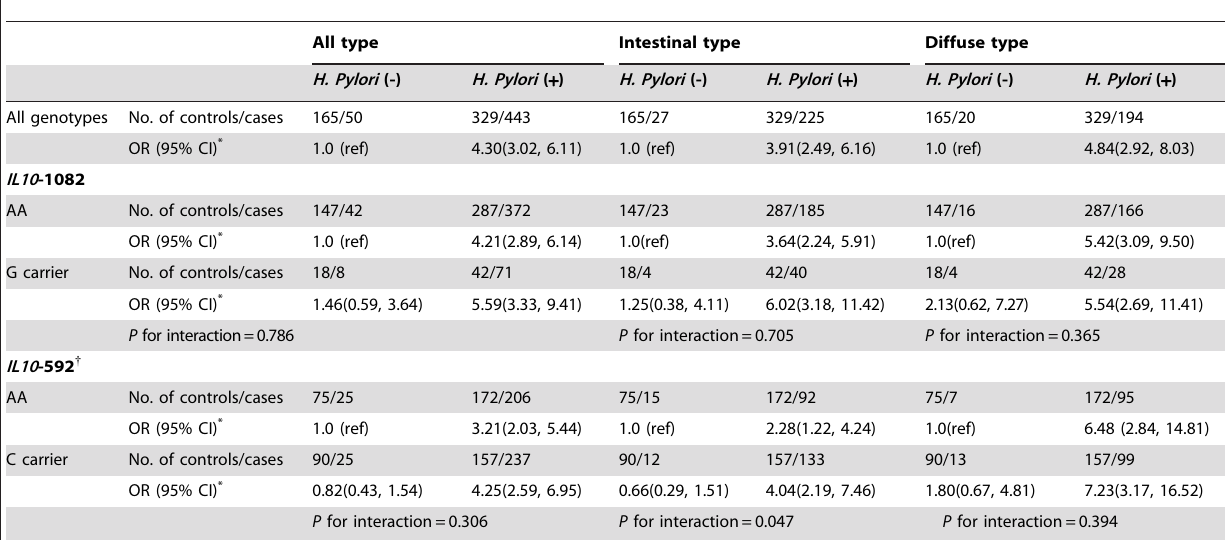
Table 3. The Effects of Helicobacter Infection Status on the Association between IL10 Genetic Variants and the Risk of Noncardia Gastric Cancer, Stratified by Histological